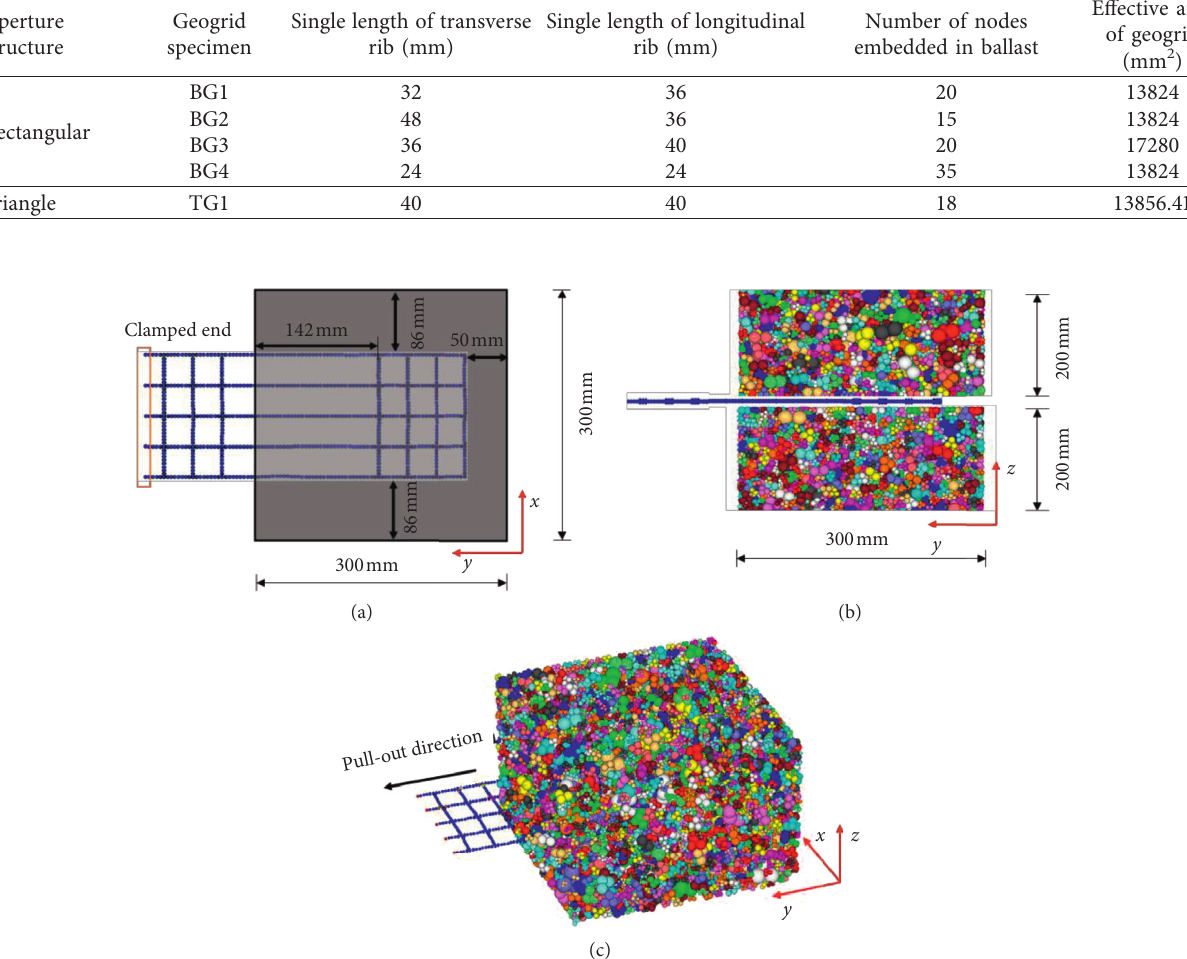
Figure 3: Establishment process of the numerical model for the pull-out test. (a) Plane view of geogrid configuration. (b) Two layers of initial ballast (front view). (c) Model of the pull-out